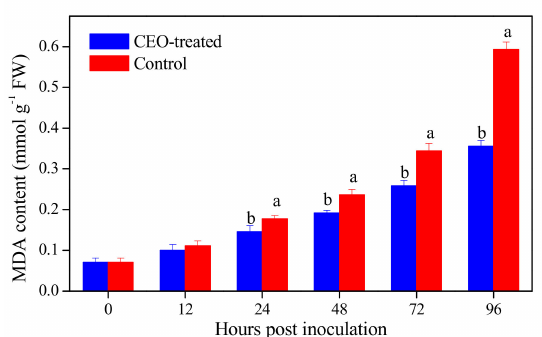
Figure 2. Malondialdehyde (MDA) content in citrus fruit treated with CEO (0.4%, v / v ) infected with P. italicum , and incubated at 25 ◦ C for 96 h. Each value represents the mean of three replicates ± standard error (S.E.). Di ff erent lowercase letters indicate significant di ff erences ( p < 0.05) between CEO-treated and control group at the same time by Tukey HSD